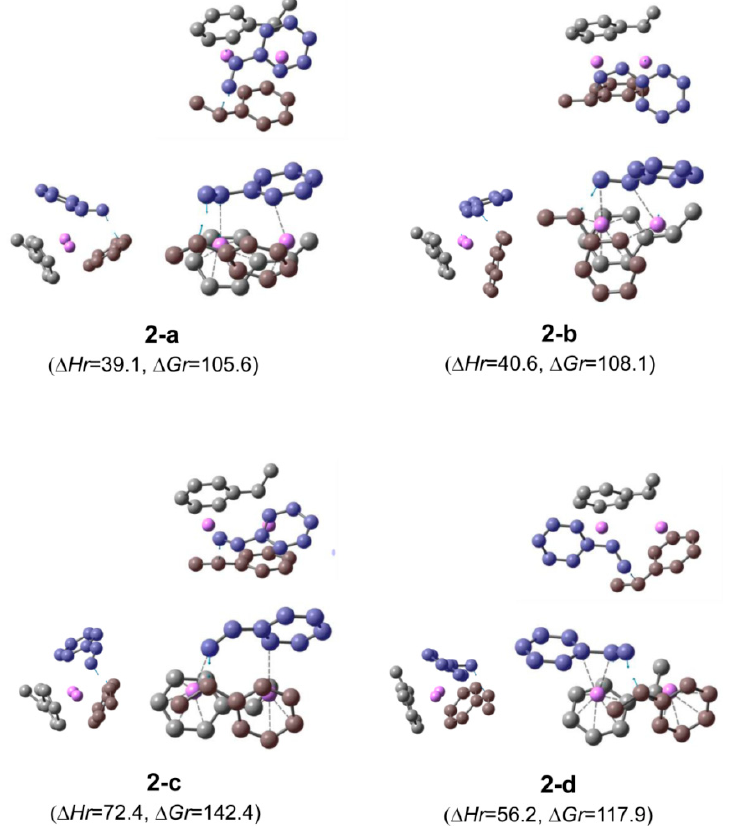
Figure 2. Optimized geometries and relative energies of typical transition states in the gas phase for the addition of styrene to (HStLi) 2 ( 1-a ), i.e., (HStLi) 2 with the lowest ∆ G r , shown in Figure 1. The small drawing on the left side of each structure is the side view of the right-hand side drawing and the drawing on the top is the overhead view of the lower drawing. The carbon atoms of styrene are colored in blue, while those of the reacting HSt- group are colored in brown. The blue arrows in each drawing indicate vectors of imaginary frequency corresponding to each transition state. Detailed arrangements of each structure are shown in the Arrangement column in Table 1 and also in the relevant description in the main text. Hydrogen atoms are not shown. ∆ H r and ∆ G r , the relative enthalpy and free energy, respectively, are expressed in kJ·mol − 1 .